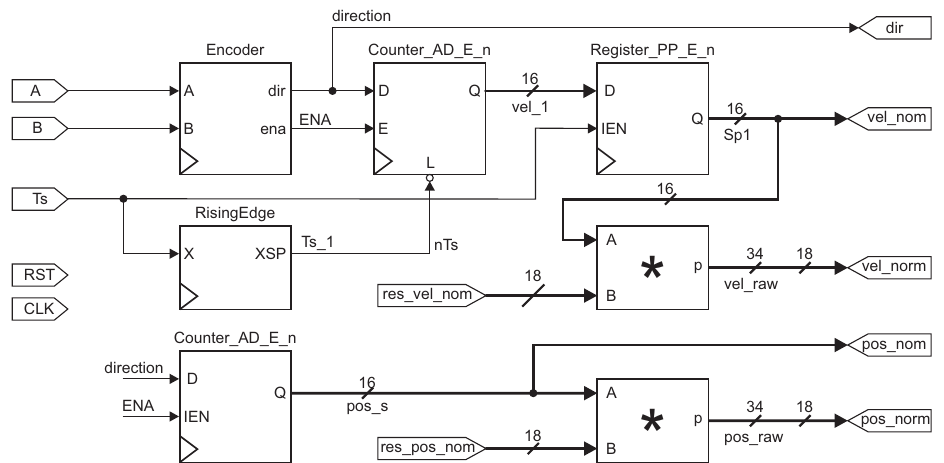
Figure 11. VHDL diagram block for the encoder configurations. The symbol * in this figure represents a multiplier module.